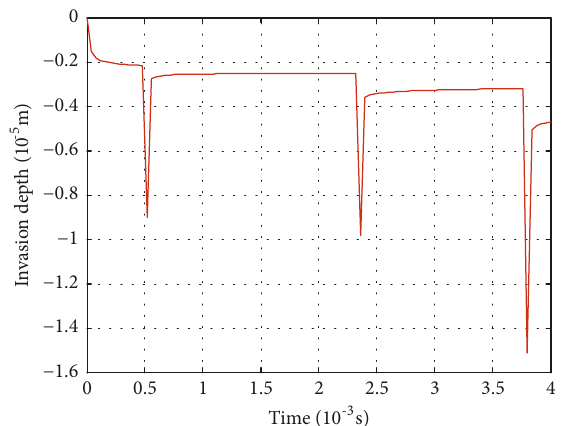
Figure 11: The invasion depth of the drill stem penetrating into the